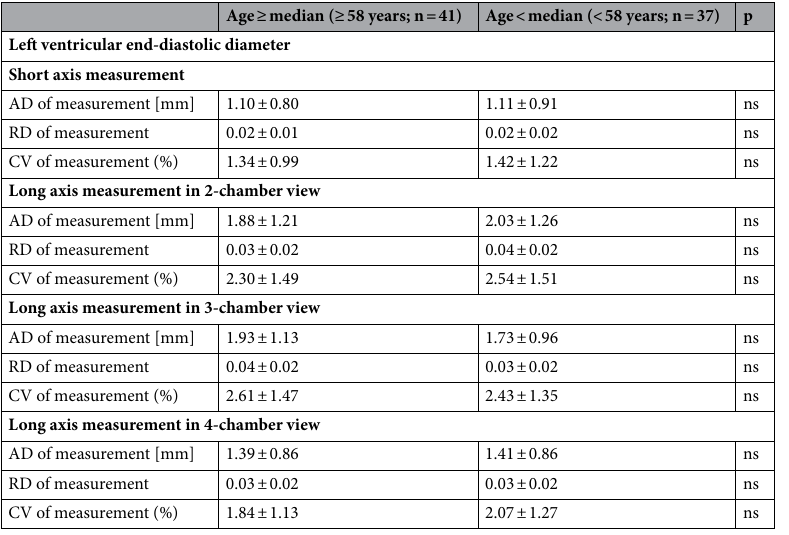
Table 4. Repeatability analysis of left ventricular end-diastolic diameter measurements in CMR in age subgroups. Values are presented as mean ± standard deviation. AD absolute difference, CV coefficient of variation, RD relative difference.